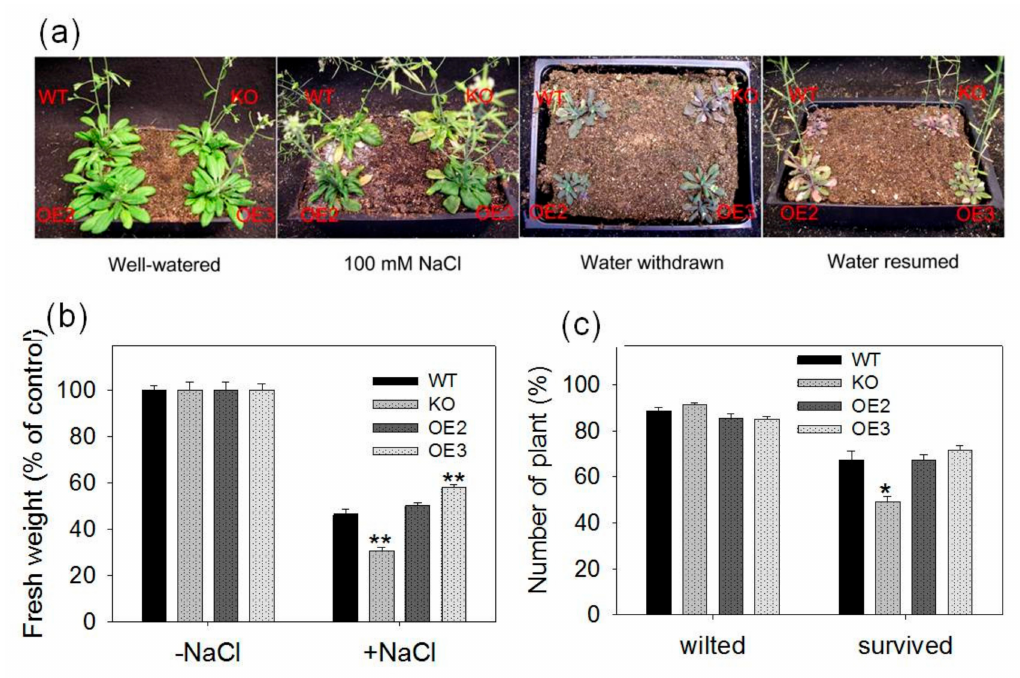
Figure 5. Soil-grown plants of WT, pPLAIII γ -KO and OE mutants under salt and drought stress; ( a ) images of plants that were watered regularly (well - watered), treated with 100-mM NaCl for 20 days (100-mM NaCl) or deprived of water for 16 days (water withdraw) and then watering was resumed (water resumed). Three-week-old seedlings were used for NaCl and drought treatments, and drought-treated plants were rewatered and grown for 18 days; ( b ) measurement of the relative growth of WT, KO and OE lines; ( c ) measurement of wilted and survived plants when water was withdrawn ( wilted ) and survived plants that wilted plants were watered again when water was resumed ( survived ). Error bars represent standard error (four biologic repeats). One and two asterisks indicate significant di ff erences from WT by Student’s t-test at p = 0.05 and p = 0.01,